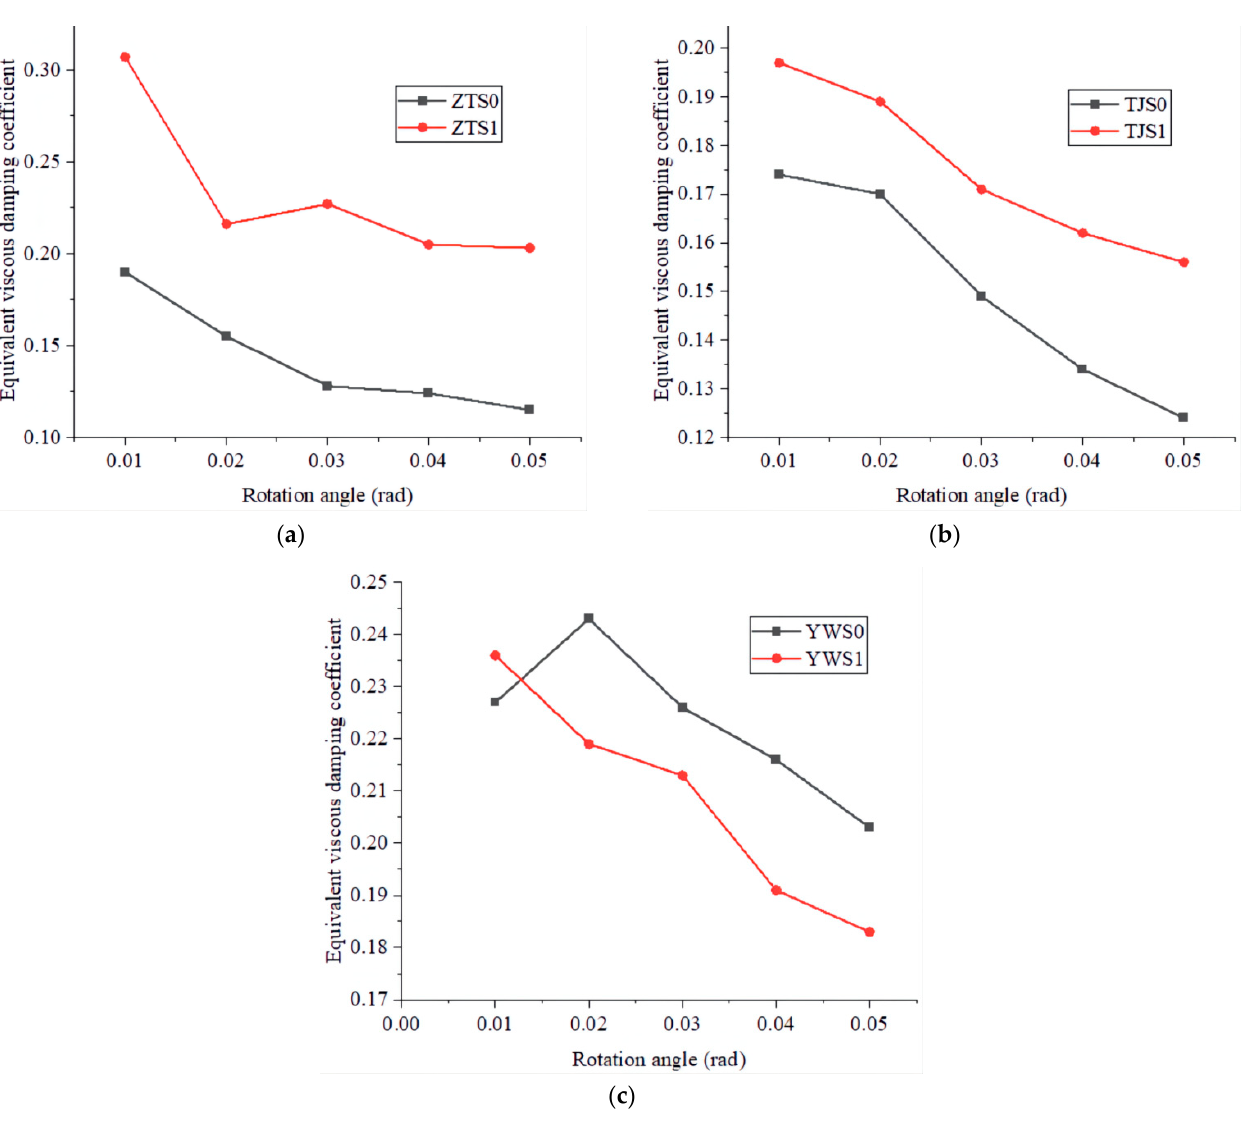
13 of 18 Figure 12. Schematic diagram of calculation method of equivalent viscous damping coefficient. The variation curve of the equivalent viscous damping coefficient he of each joint with the rotation angle is shown in Figure 13. In general, the energy dissipation capacity of all unreinforced joints decreases with the increase of the angle, because the energy dissipation of joints mainly depends on the friction between the tenon and the socket and the compression deformation. In the process of repeated loading, the friction surface between the tenon and the socket is gradually smooth, and the plastic deformation caused by the compression is gradually reduced. From the curve comparison, it can be seen that the equivalent viscous damping coefficient of the dovetail joint in the unreinforced joint is the largest, and the reason can be analyzed from the calculative equation: First, as for the molecular term, although the interaction between the top, bottom and the mortise during loading is reduced due to the halving of the length of dovetail joint, the two sides and the mortise will also be squeezed and rubbed